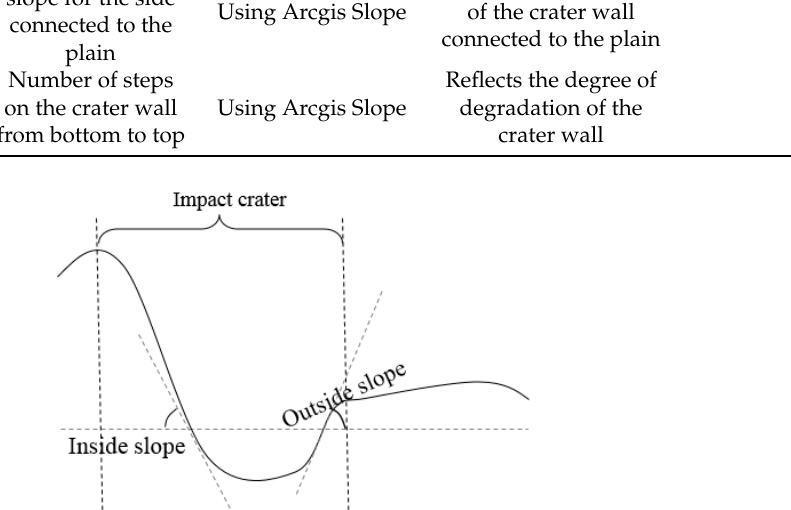
Figure 6. The inner crater wall of Copernicus (from NASA, [52]). Table 3. Indices for description of the crater wall.